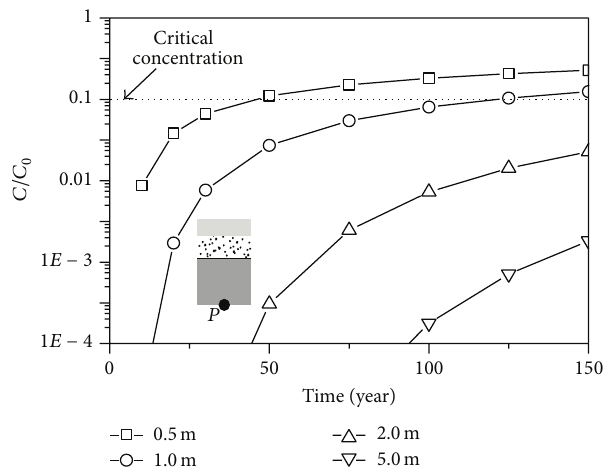
Figure 9: Comparison of concentration-time with different CCL thicknesses.